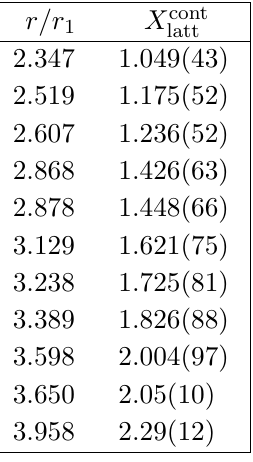
Table 3 . Numerical results of X cont